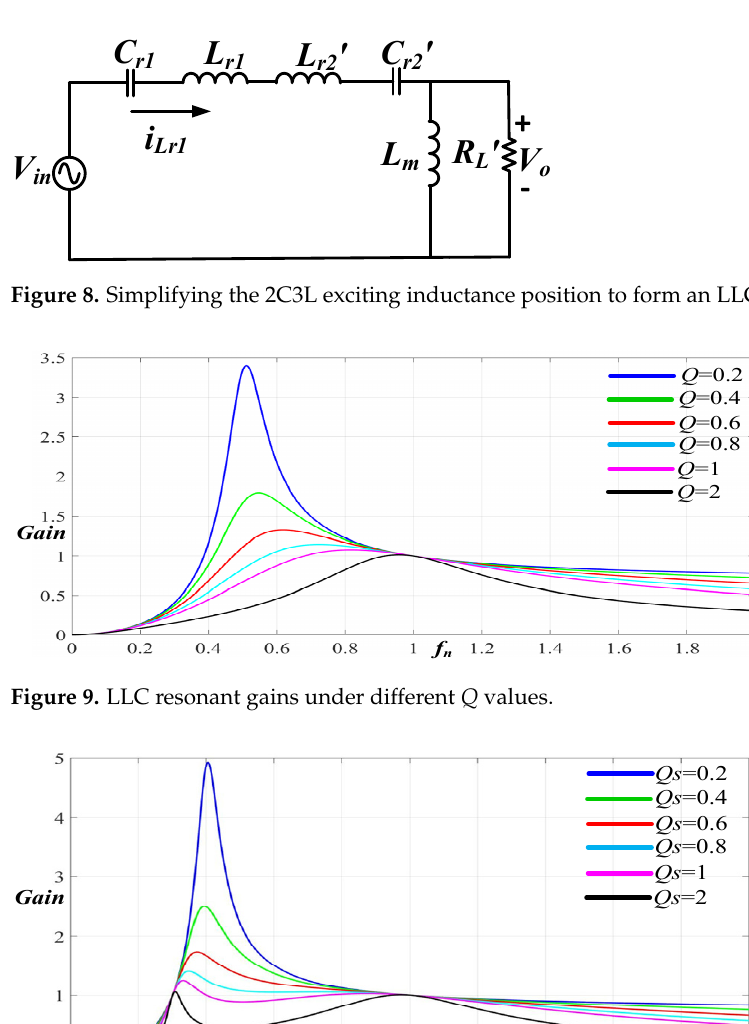
k =5 k =5 Figure 11. Effects of the k value on the frequency modulation. 3.